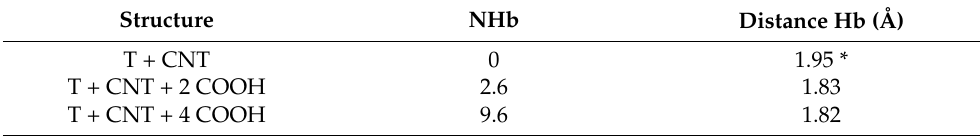
Table 5. Number of H bonds and their average length (E